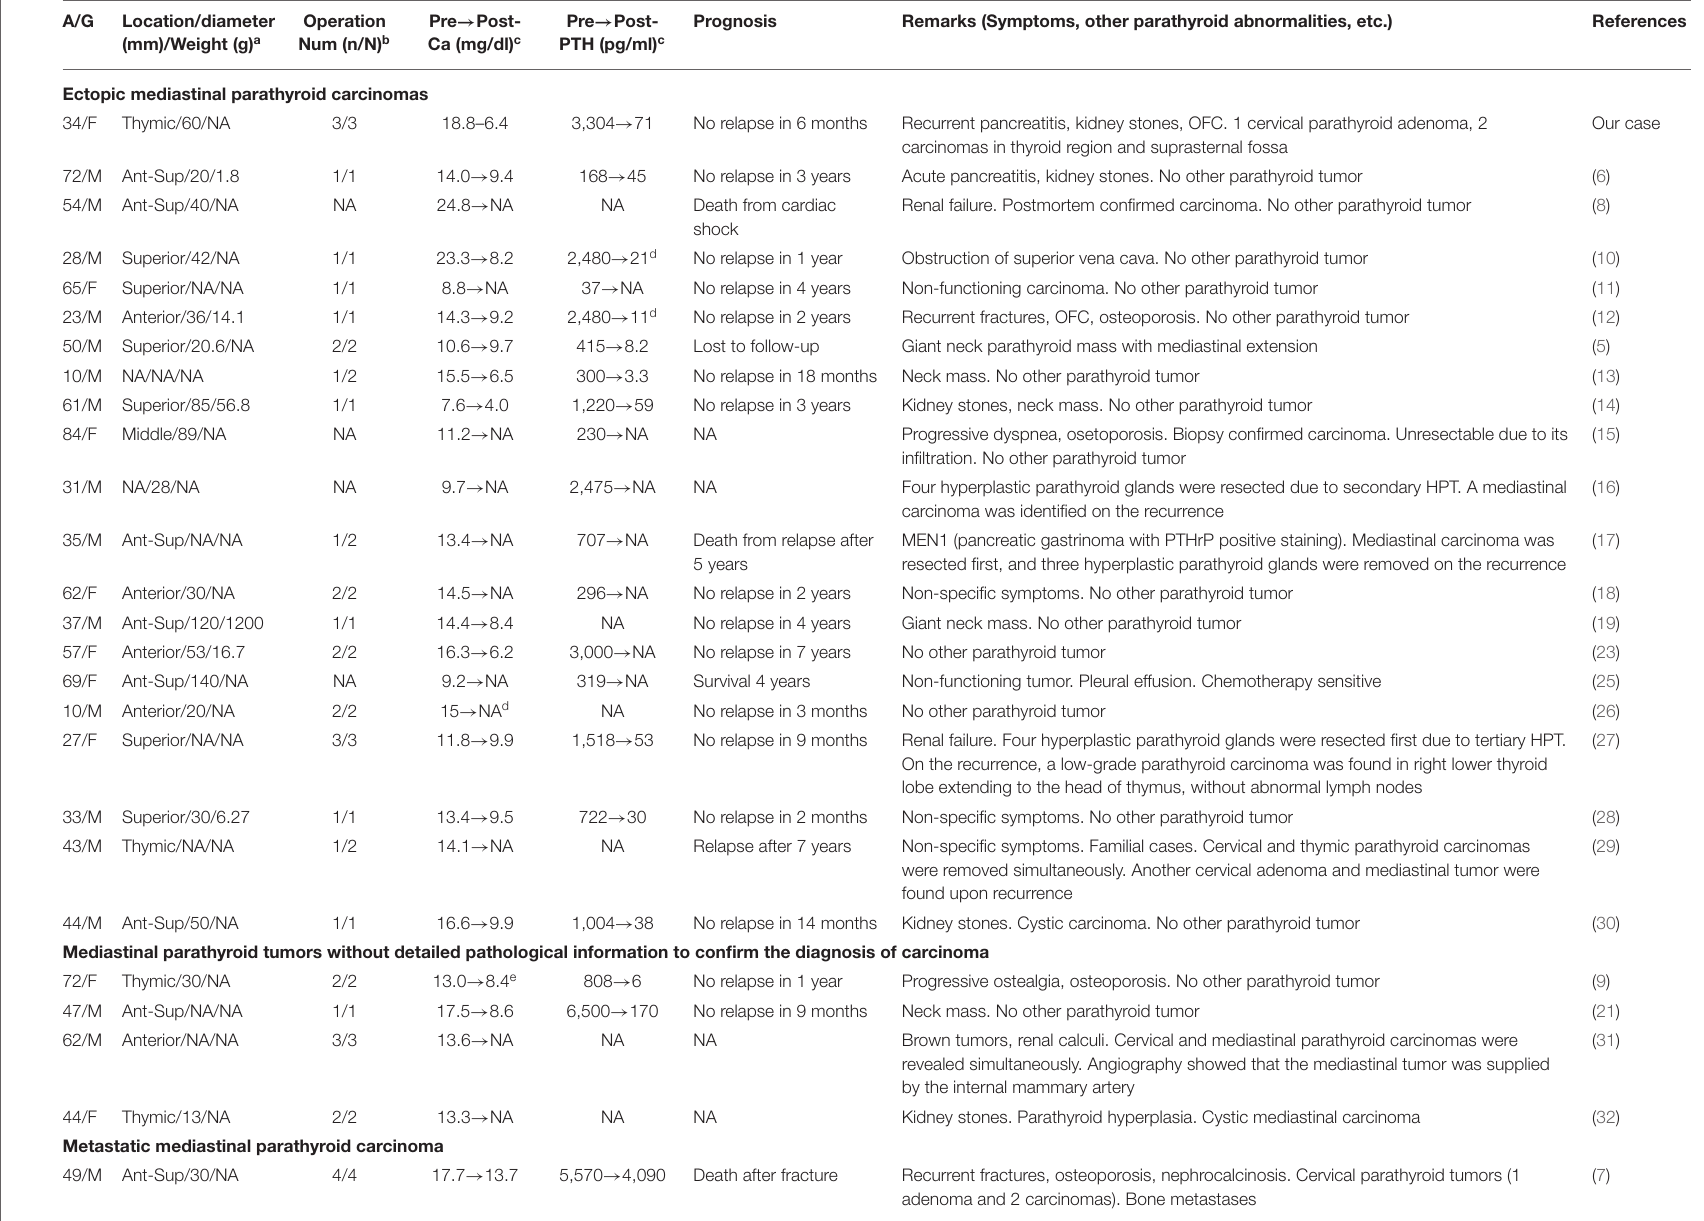
TABLE 1 | Literature review of mediastinal parathyroid carcinomas.